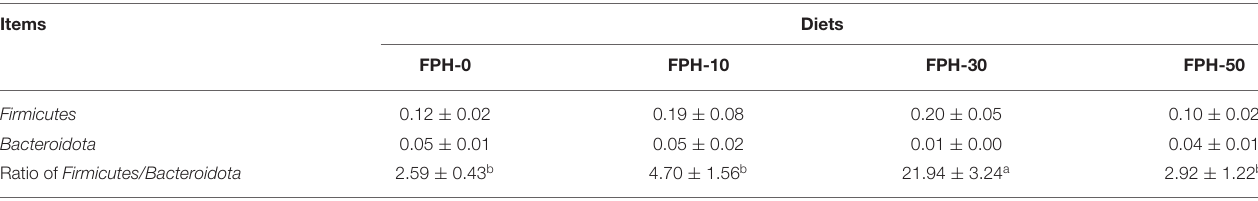
TABLE 9 | Relative abundance of Firmicutes , Bacteroidetes and Ratio of Firmicutes/Bacteroidota in the intestine of largemouth bass ( Micropterus salmoide s) fed the diets containing different supplementation levels of fish protein hydrolysate (FPH)*. Items